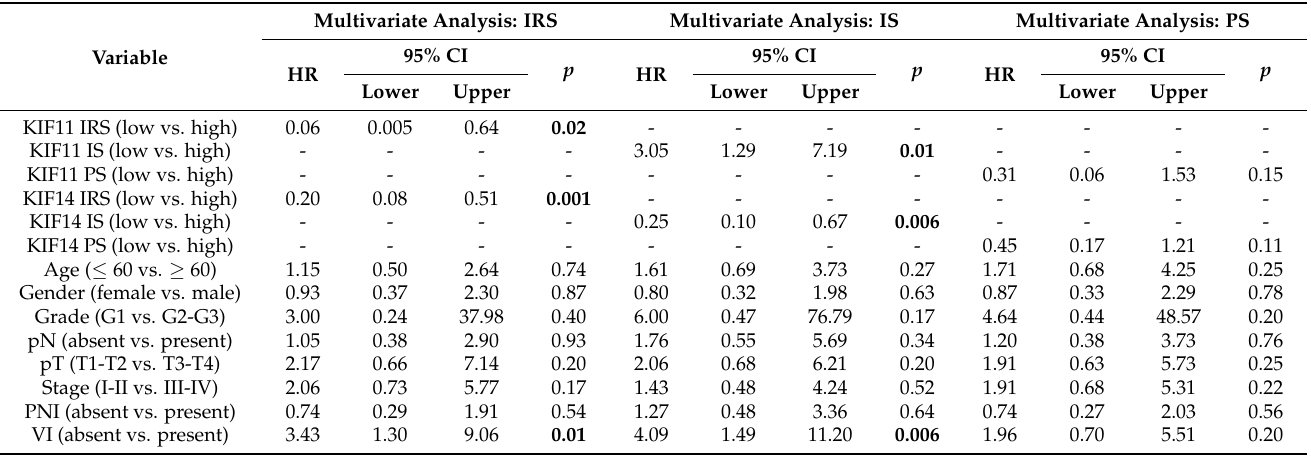
Table 4. Multivariate Cox proportional hazards models for overall survival of pancreatic ductal adenocarcinoma patients.